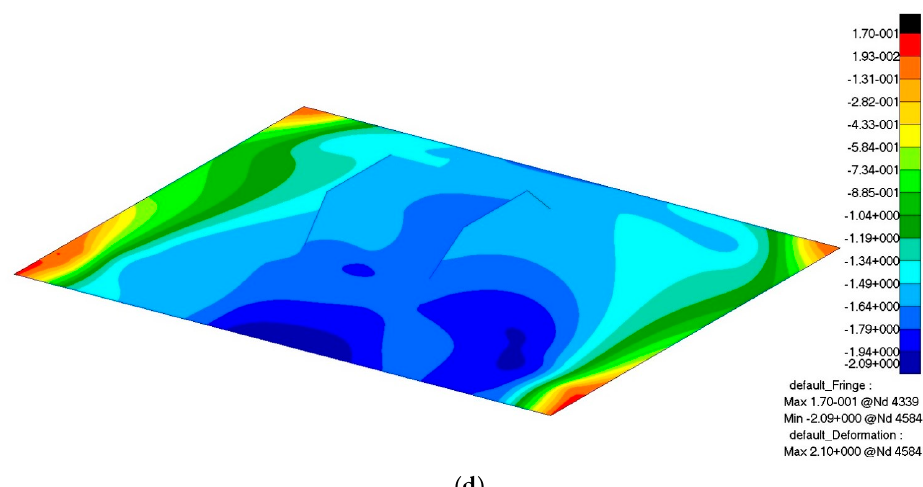
Figure 9. ( a ) Subcase 3: population reduction after topology optimization, ( b ) Subcase 3: optimum layout maximum deformation, ( c ) Subcase 4: population reduction after topology optimization, ( d ) Subcase 4: optimum layout maximum deformation.